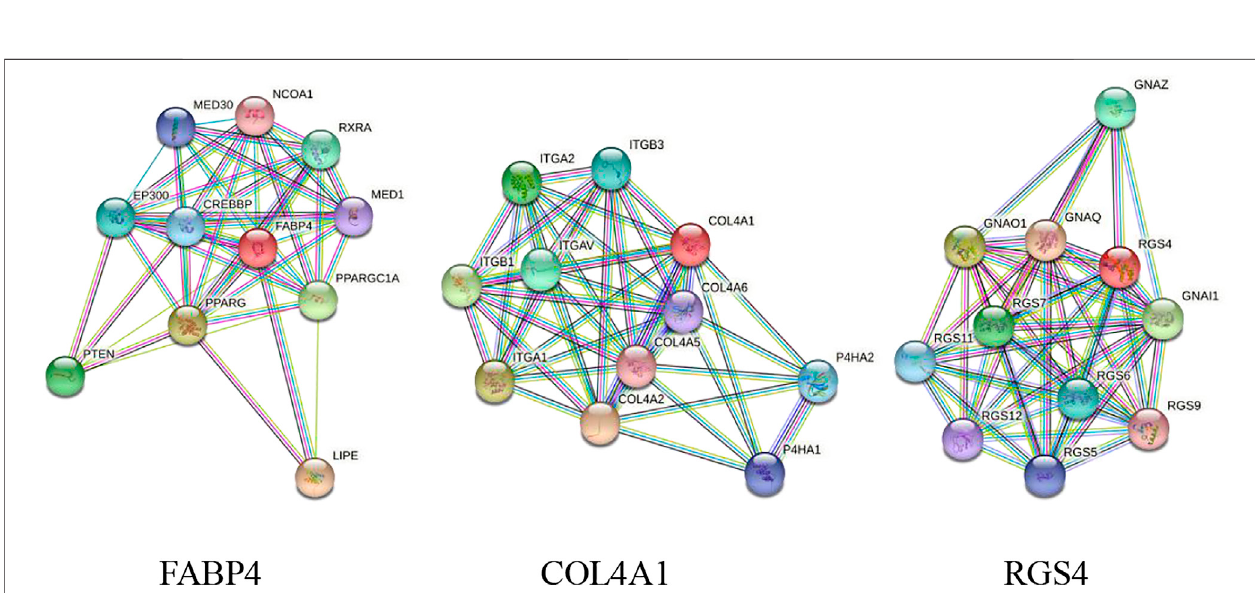
FIGURE 6 | PPI network of DEGs obtained from the STRING database. The protein network was calculated based on the neighborhood score with higher con fi dence (con fi dence score > 0.99).